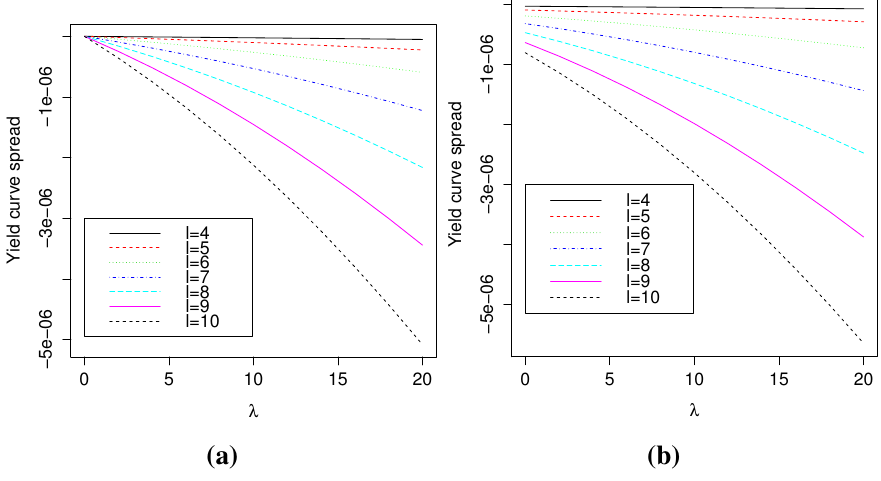
Figure 3. Difference between the best-estimate and no-arbitrage yield for times to maturity (cid:96) from 4 to 10, L = 3 , for different market risk premium parameter λ . ( a ) λ